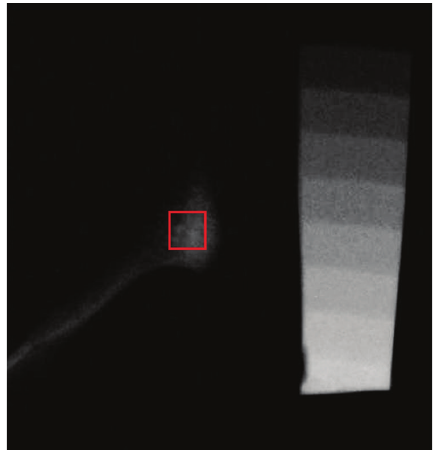
Figure 3: Radiographic image of rabbit condyle and aluminum step wedge from ZA-treated group.